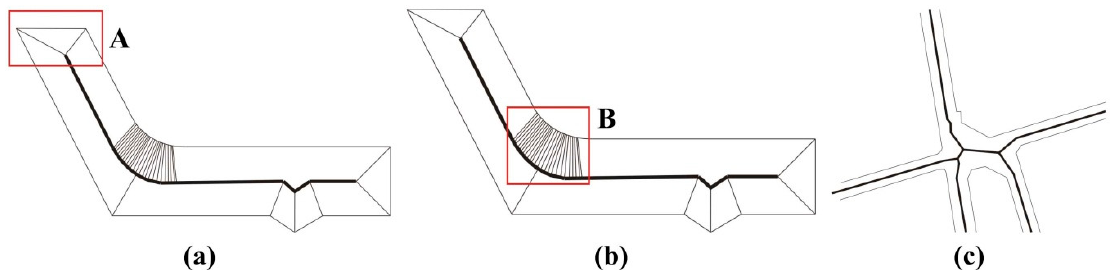
Figure 2. Problems with extracting straight skeletons: ( a ) changes to the topological relation at the end, ( b ) dense straight skeletons and ( c ) jitter at the branch junctions.